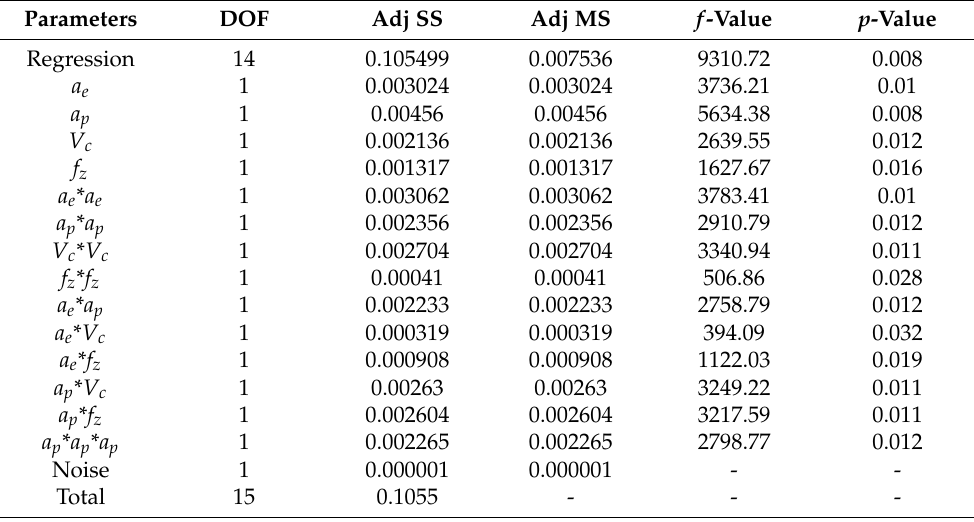
Table 7. ANOVA for